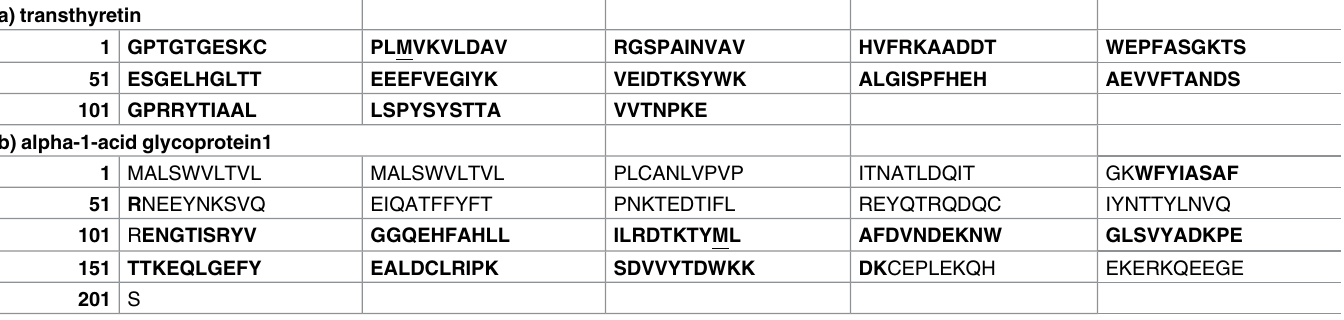
Table 1. Matched protein sequences of serum